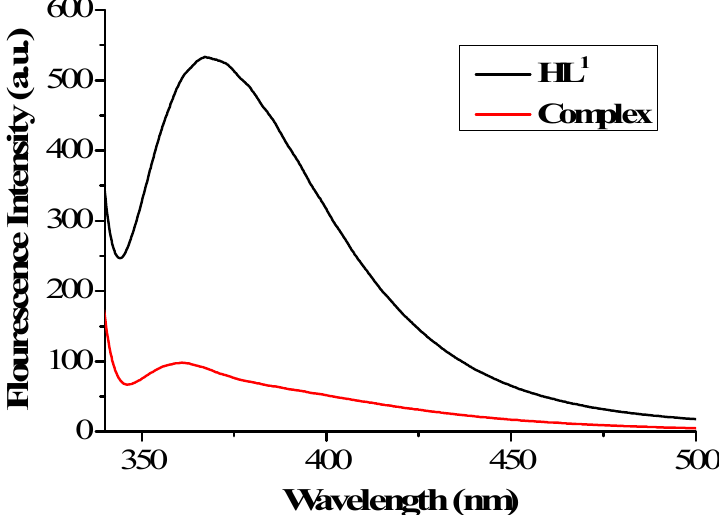
Figure 6. Fluorescence spectra of HL 1 and the Co(II) complex upon excitation at 320 nm (ethanol, 5.0 × 10 − 5 M).